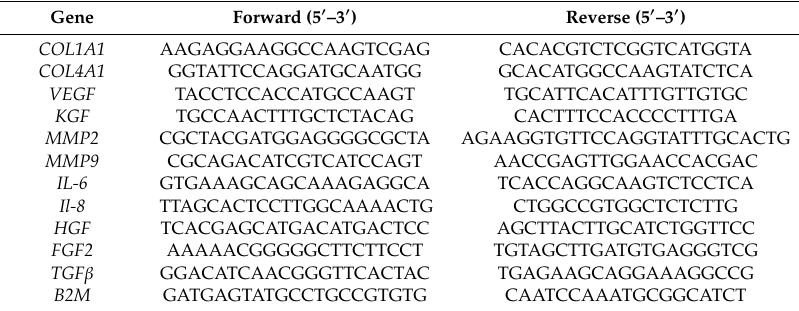
Table 1. Primers used for real-time